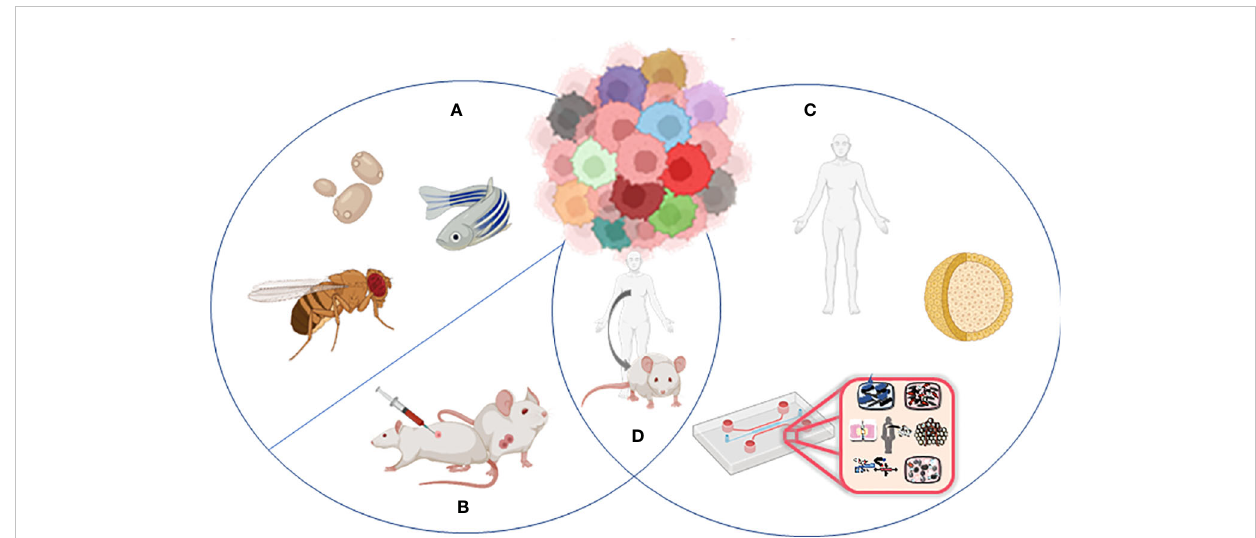
FIGURE 2 Models to study tumor heterogeneity: (A) non-murine models ( Drosophila melanogaster, Danio renio , Saccharomyces cerevisiae ), (B) murine models (syngeneic models, GEMMs), (C) human in vitro models (organoids, organ-on-chip), and (D) humanized murine